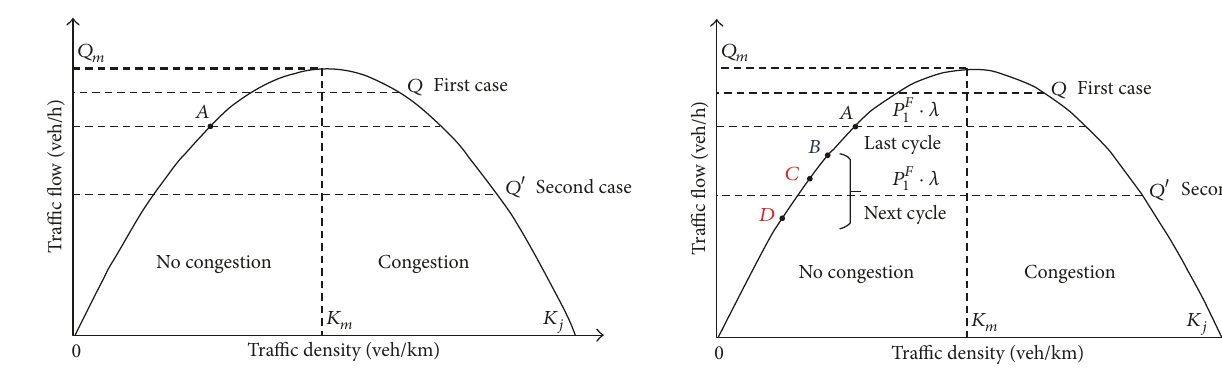
Figure 3: Decrease of expected number of agents entering route per unit